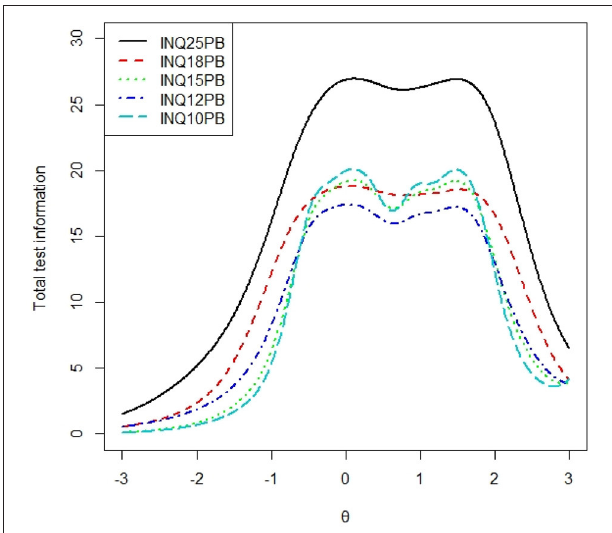
FIGURE 3 | Average test information curves of perceived burdensomeness of each version.